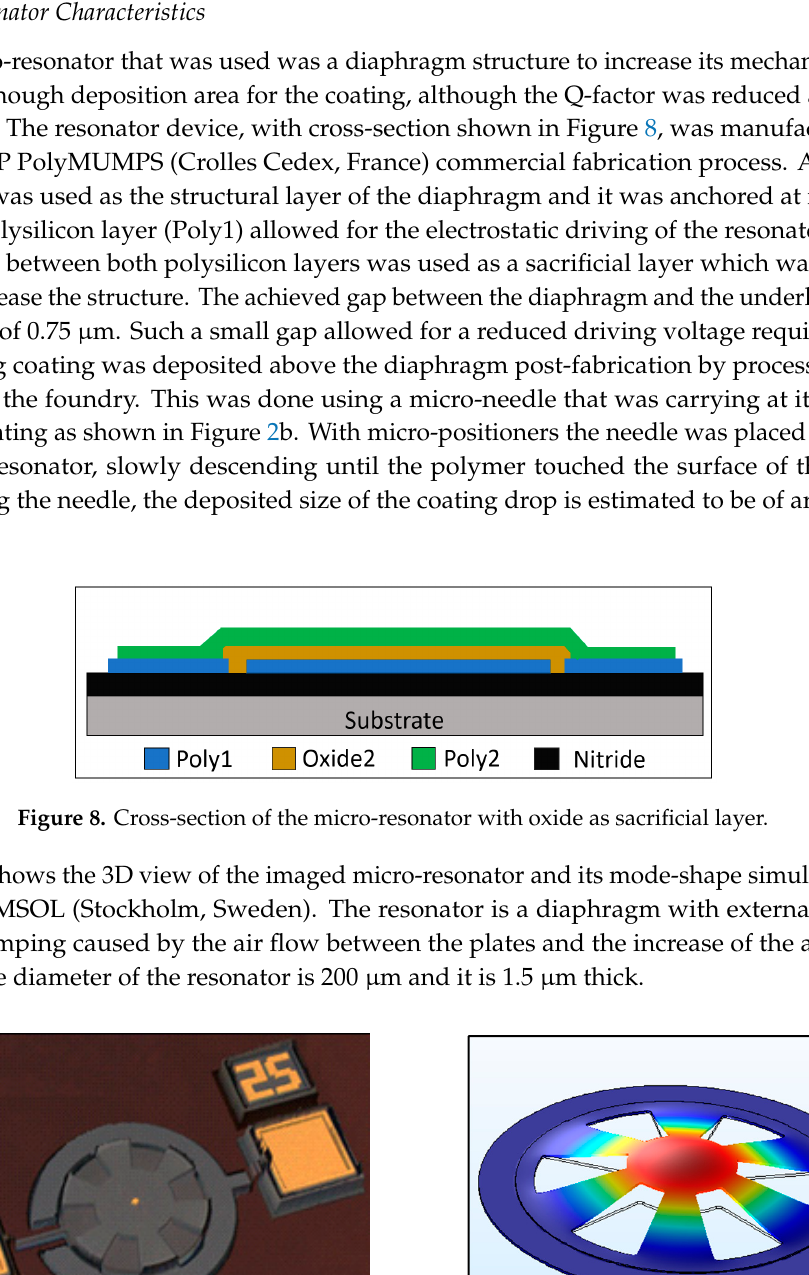
Figure 9. ( a ) Three-dimensional (3D) view of the real micro-resonator obtained by the Olympus (Shinjuku, Tokyo, Japón) LEXT OLS4000-Confocal microscope, ( b ) Eigenfrequency FEM COMSOL simulation of the first mode of resonance of the microelectromechanical systems (MEMS)